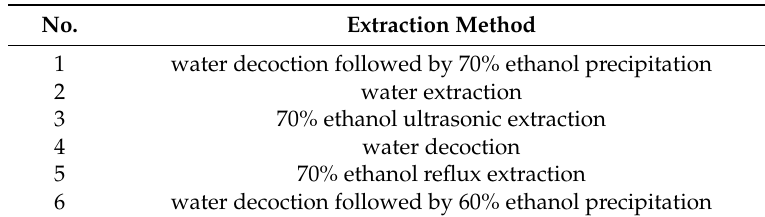
Table 1. Extraction methods for Rhodiola Rose.